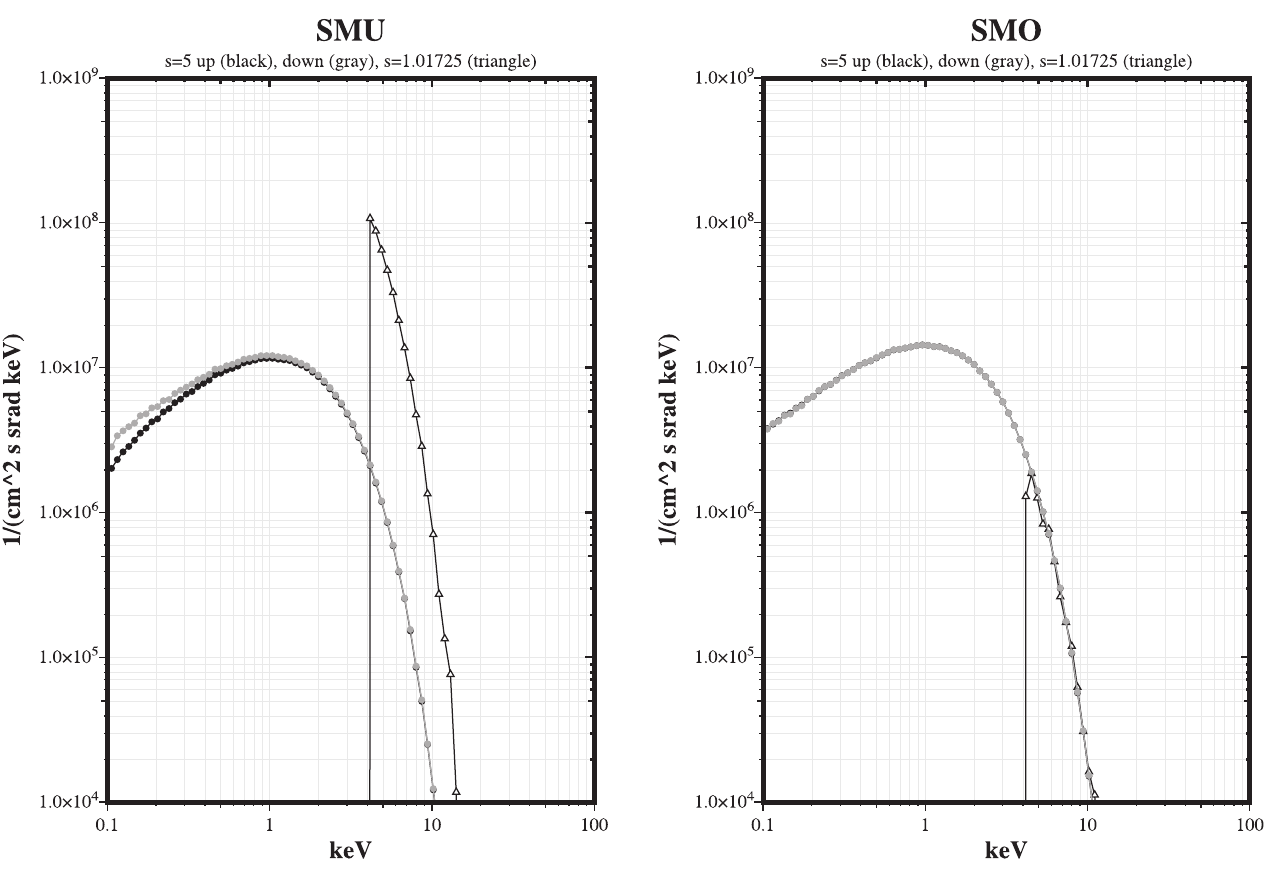
Fig. 4. SMU: single-Maxwellian source plasma and a U-shaped potential. This is the classical picture, where a potential drop accelerates the electrons